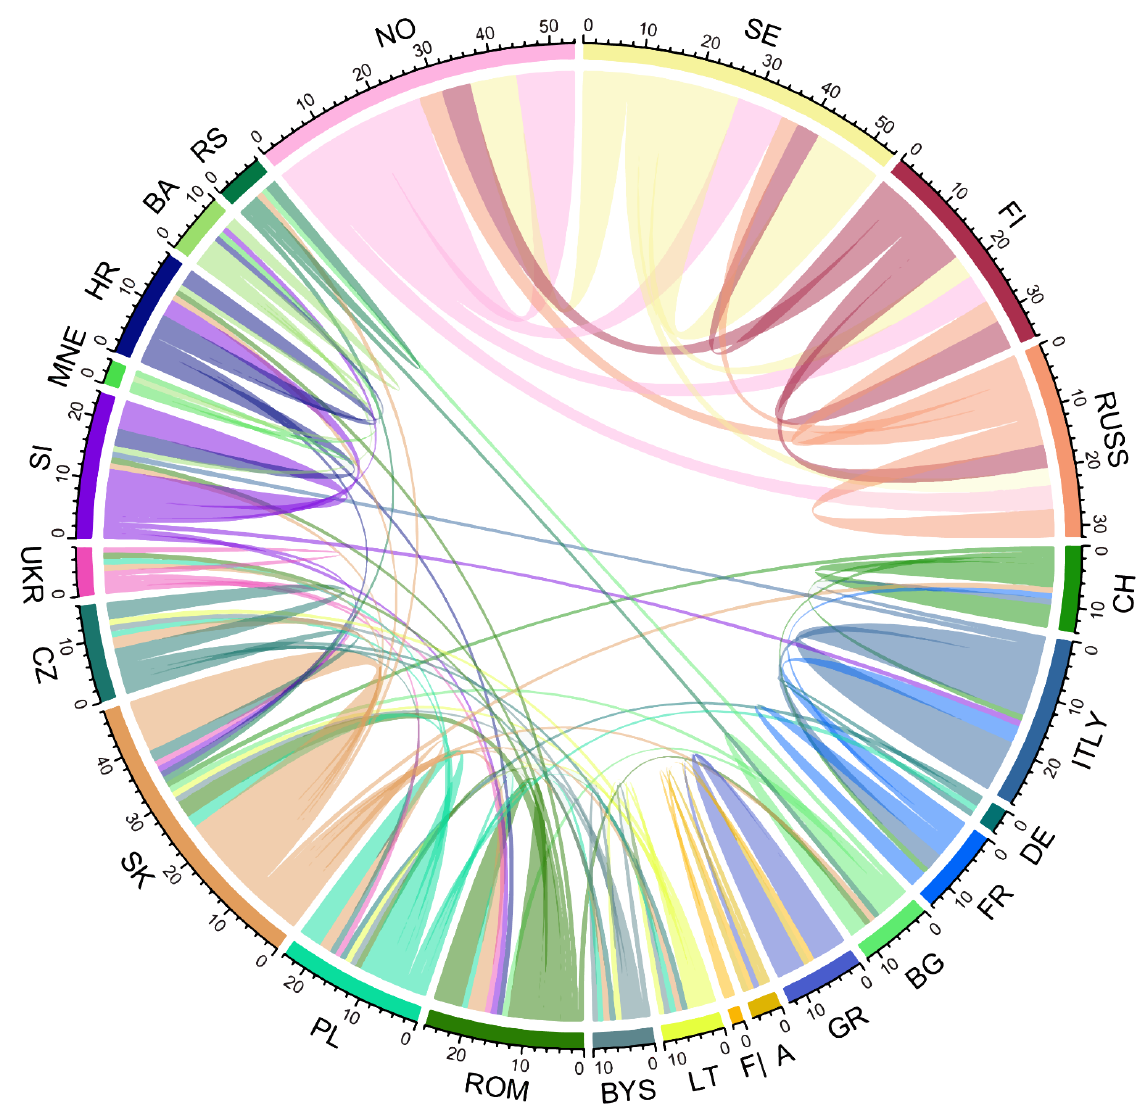
Figure 7. Graphic representation of the international cooperation found between our studies (see Table A1 for country acronyms. A = Albania, F = Former Yugoslav Republic of